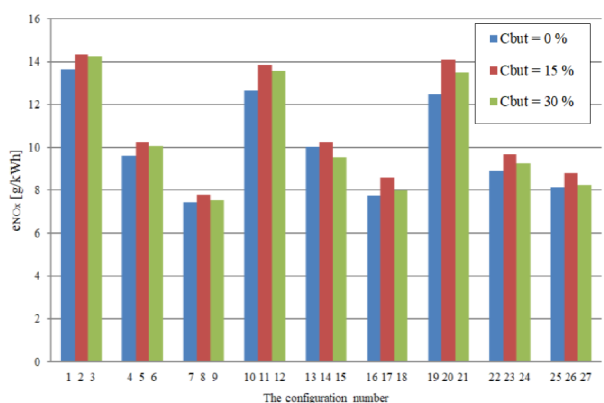
Fig. 4. Comparison of the specific NO x emission for the engine fed with blend n-butanol fuel and MDF